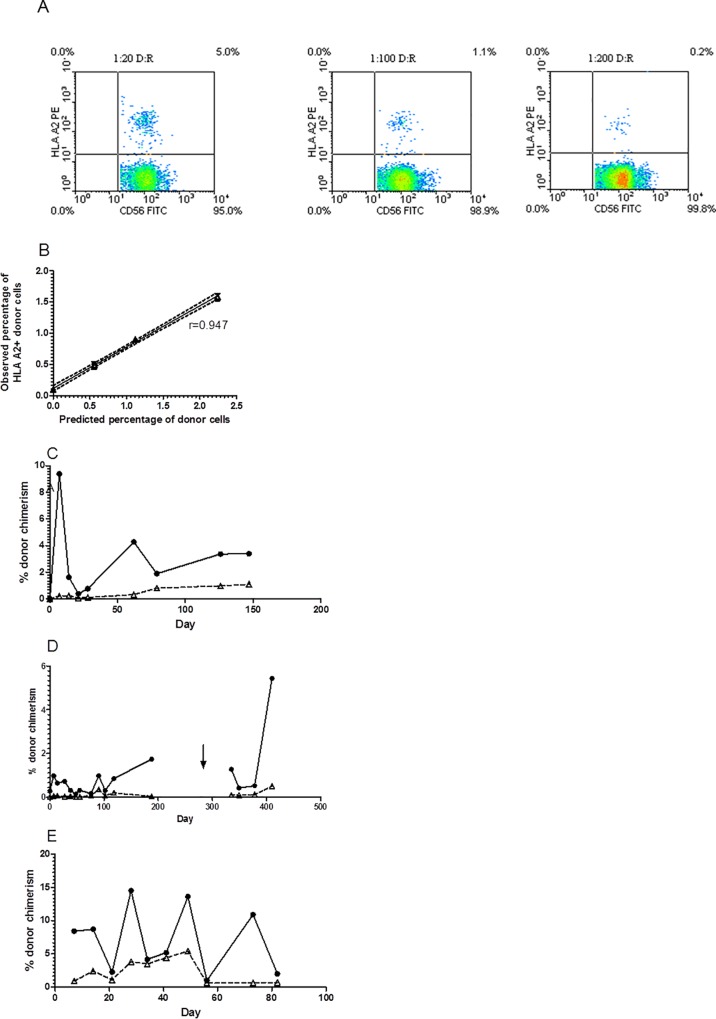
Donor NK chimerism.Donor NK chimerism was measured by flow cytometry using monoclonal antibodies specific for an MHC Class I allele which was restricted to the donor cells. Concomitant labeling with anti-CD3 and anti-CD56 allowed detection of donor T, NKT and NK cells in patients’ peripheral blood and bone marrow. Preliminary experiments confirmed sensitivity (A) and specificity; indeed the method consistently underestimated the dosed proportion of donor cells (B). Three evaluable patients showed consistent presence of low levels of donor NK cells (filled circles and solid line) in peripheral blood (C, D, E). Patient 01 (C) and Patient 03 (D) showed absence of donor T cells (open triangles and dashed line). Patient 04 who suffered profound marrow aplasia and required allogeneic stem cell rescue was the only one to have detectable donor T cells in repeated blood samples (E).